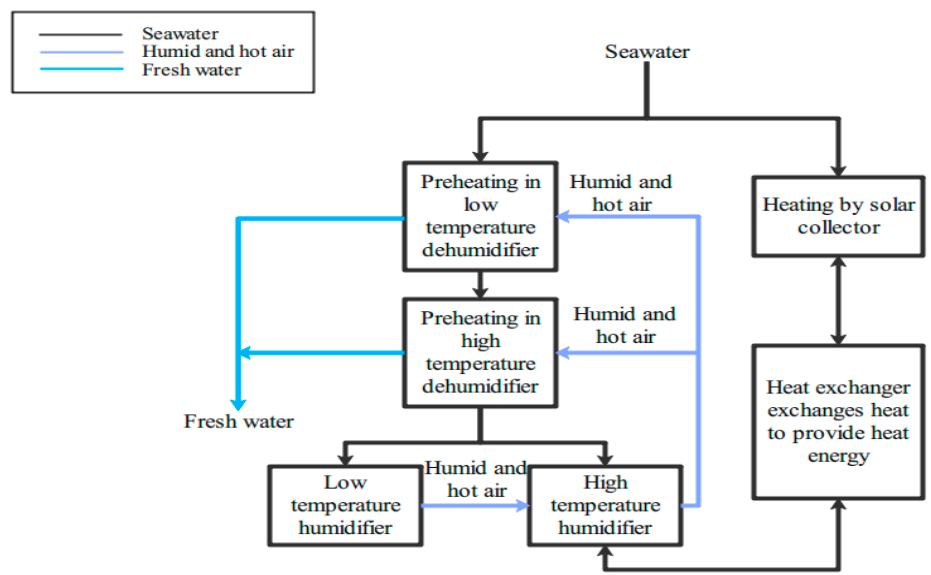
Figure 3. Schematic diagram of a two ‐ stage HDH seawater desalination device.